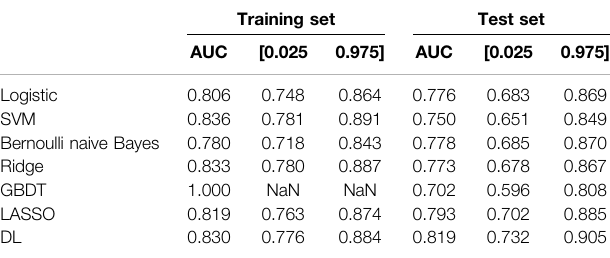
TABLE 4 | Results of the ROC analysis for different machine learning